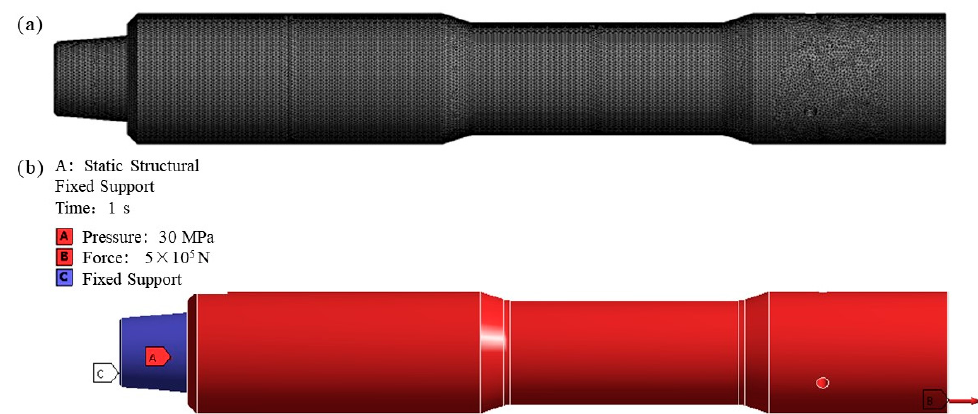
Figure 3. Meshing and boundary conditions of downhole solid–liquid separator. ( a ) Meshing; ( b ) boundary conditions.